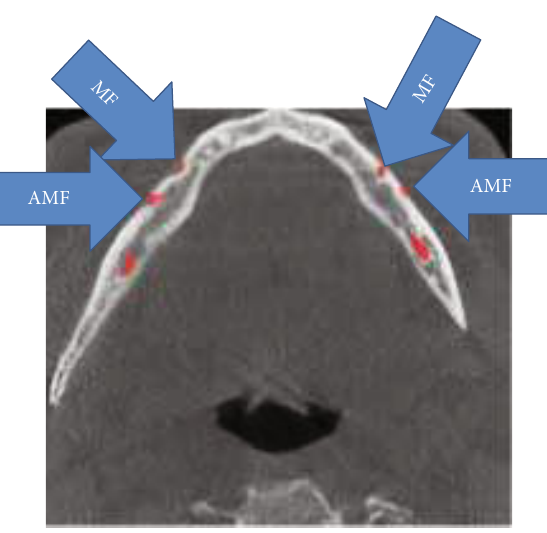
Figure 2: Right and left AMF at axial CBCT.